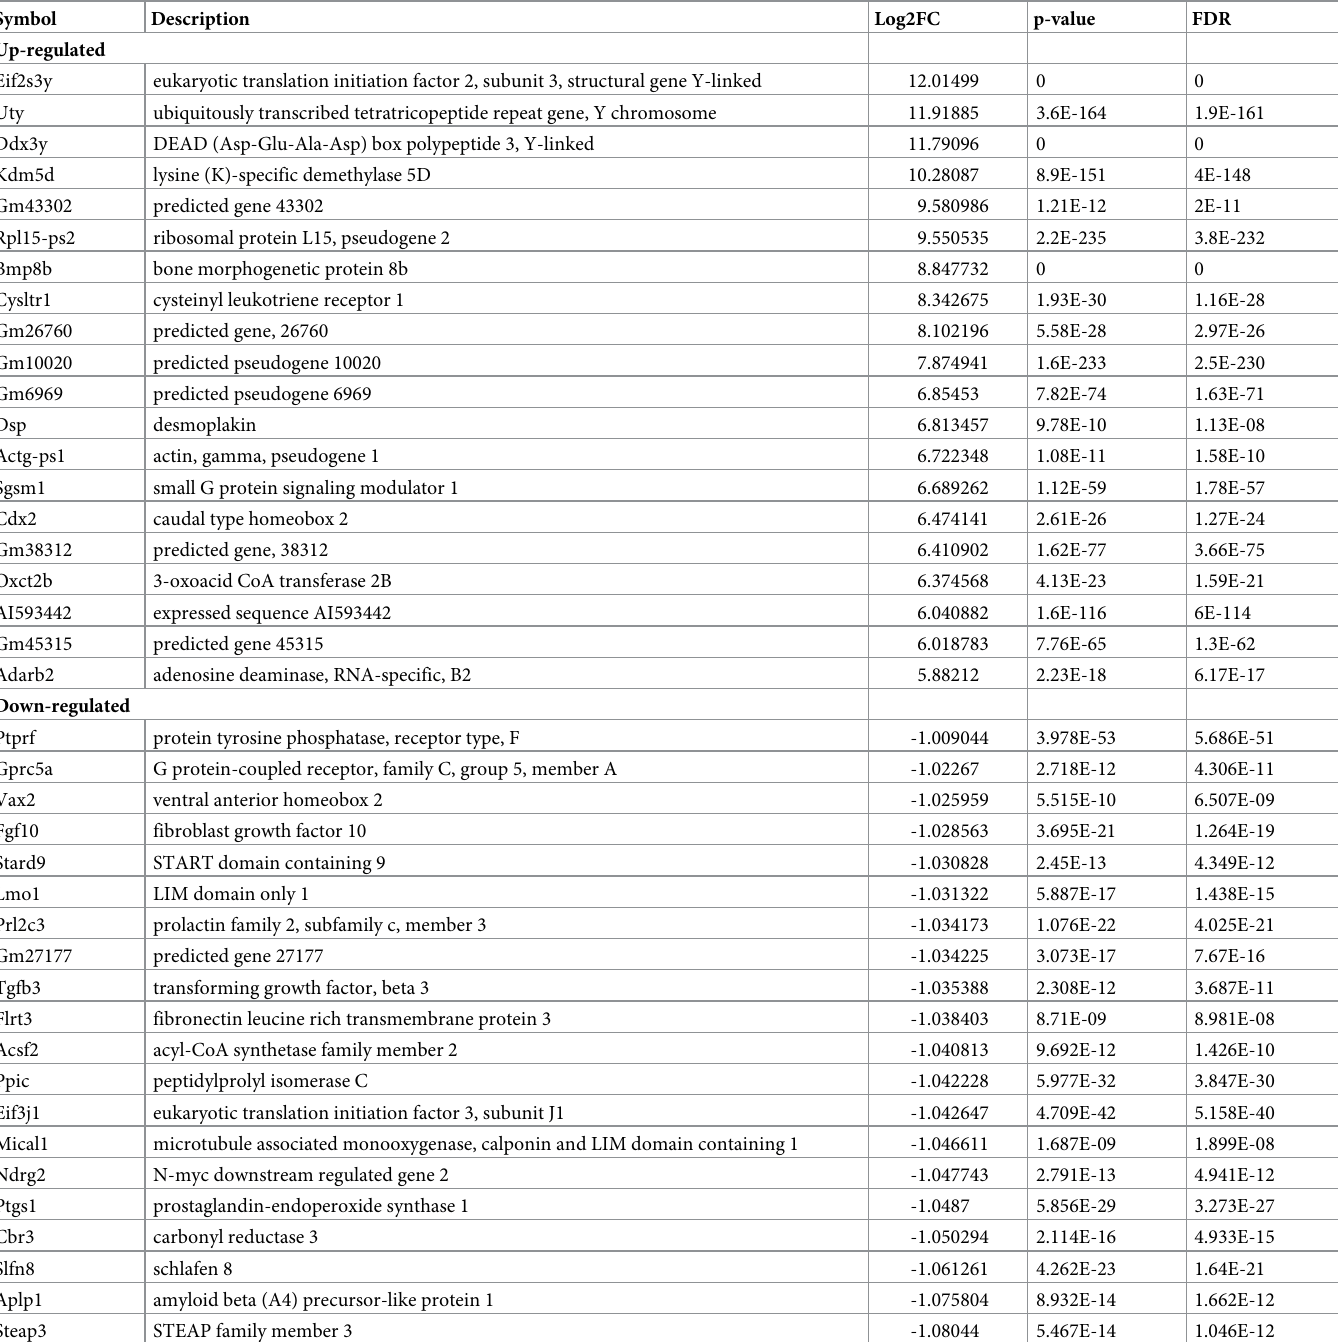
Table 1. Top 20 up- and down-regulated genes in Cyp1b1-/-AC.